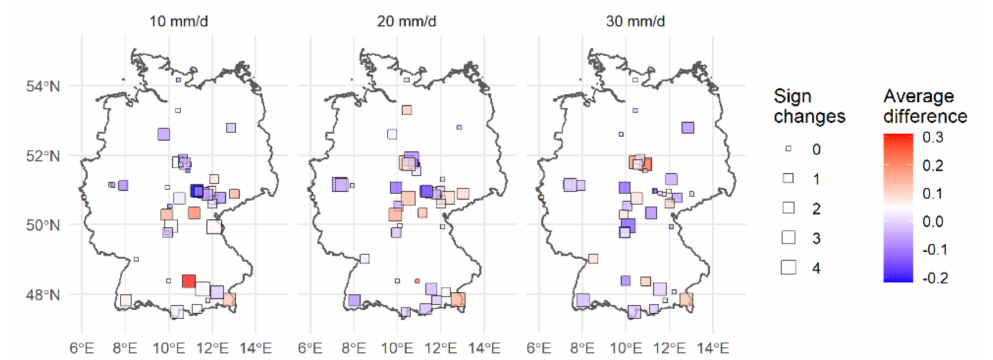
Figure 4. The di ff erence in strength and direction of Kendall’s tau between nearby stations, over all available CLINO periods.